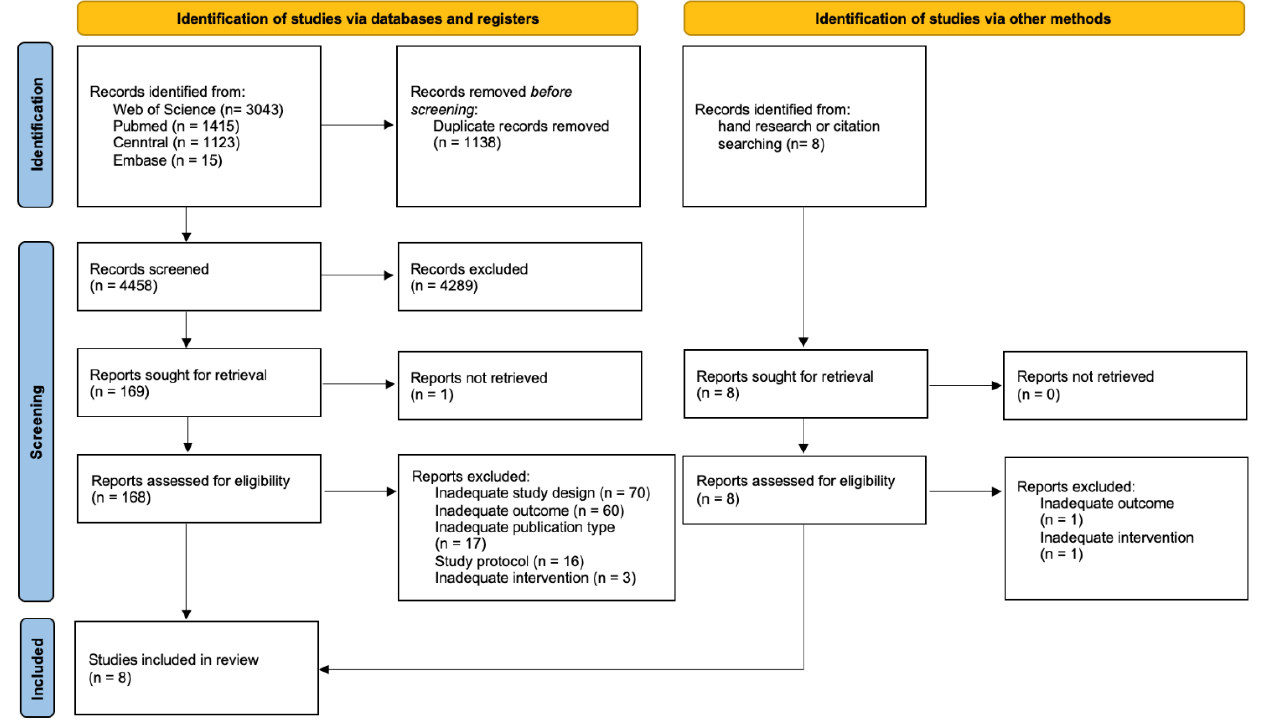
Figure 1. PRISMA 2020 flow diagram of literature search and selection process [24] .